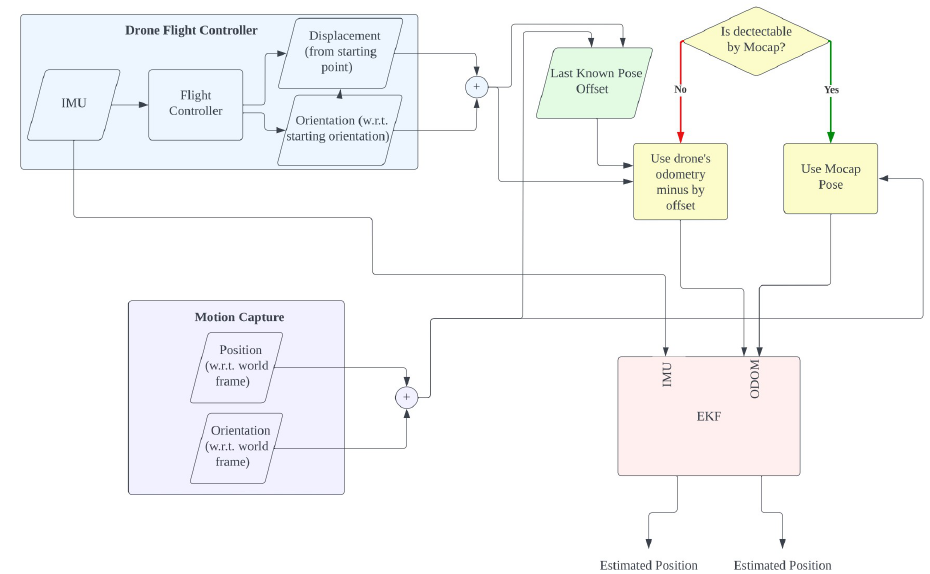
Figure 6. Flowchart of the tracking scheme using the combination of motion capture and odome- try